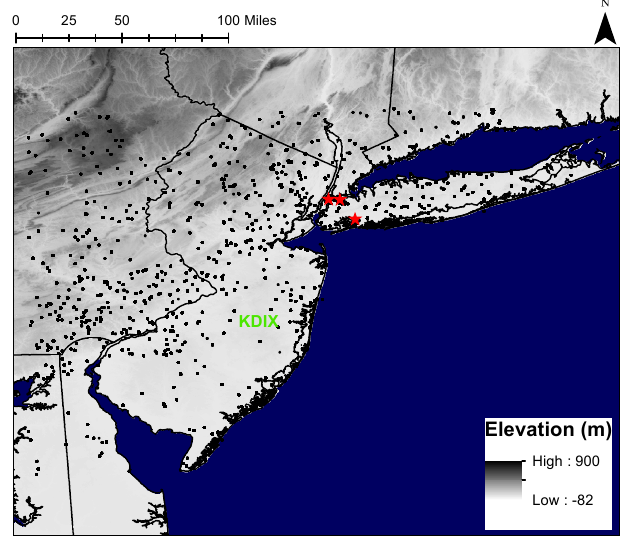
Figure 1. Study area map with elevation. The radar location in Mount Holly, NJ, is represented by the green “KDIX”, HCN rain gages are represented by red stars (Central Park to the west, JFK to the south, and LaGuardia to the northeast), and all other rain gage locations are represented by black